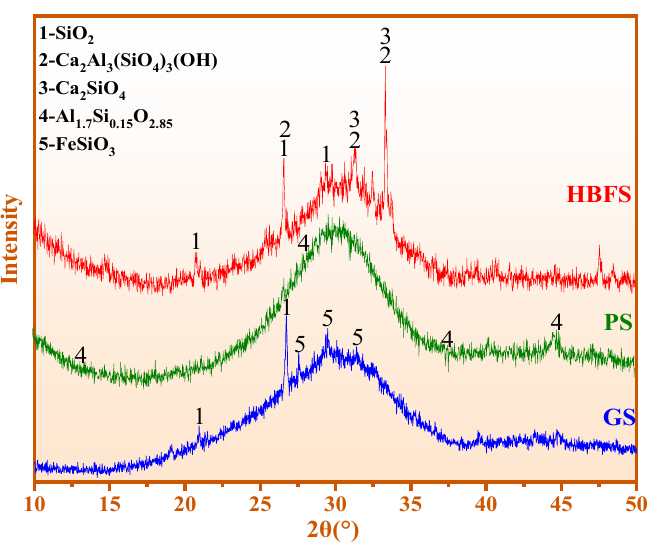
Figure 2. XRD results of HBFS, PS, and GS.